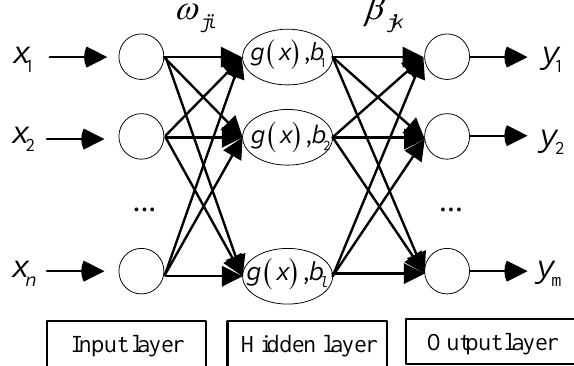
Figure 2. Extreme learning machine model.